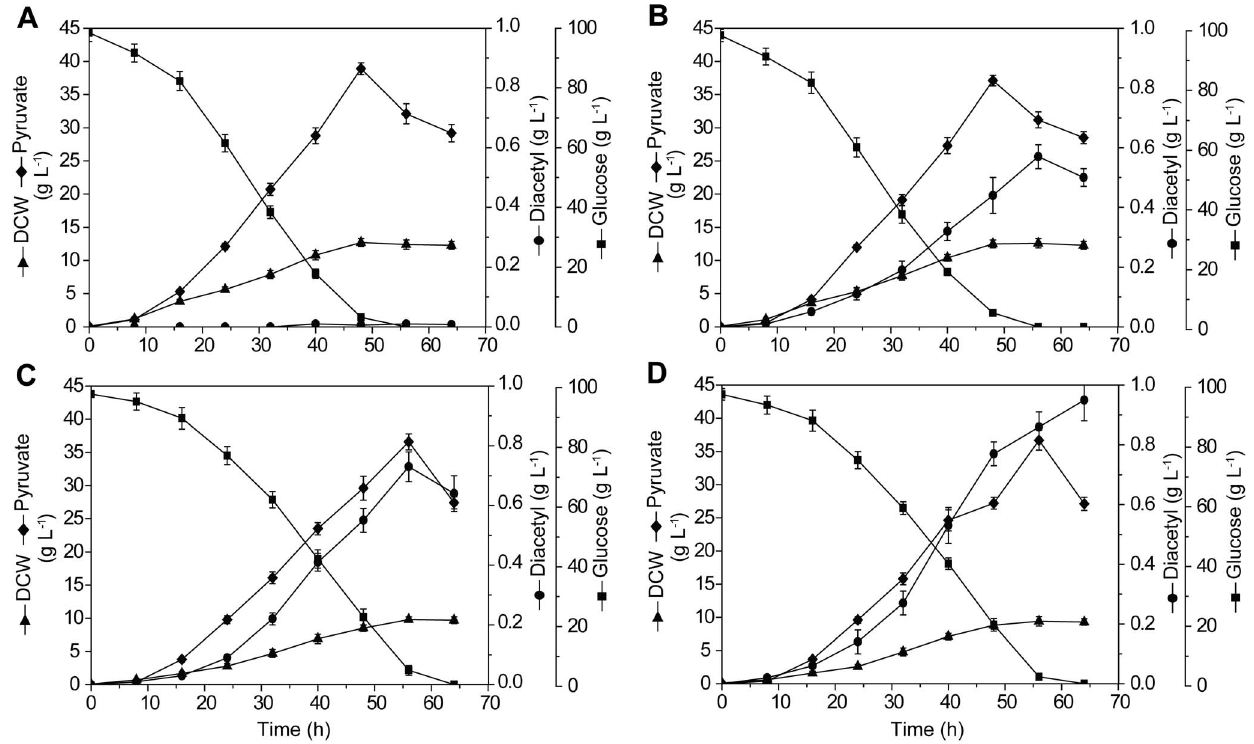
Figure 3. Fermentation profile for cell growth and product accumulation during shake-flask culture of the control strain DA-0 (A) and the engineered strains DA-1 (B), DA-2 (C), and DA-3 (D).